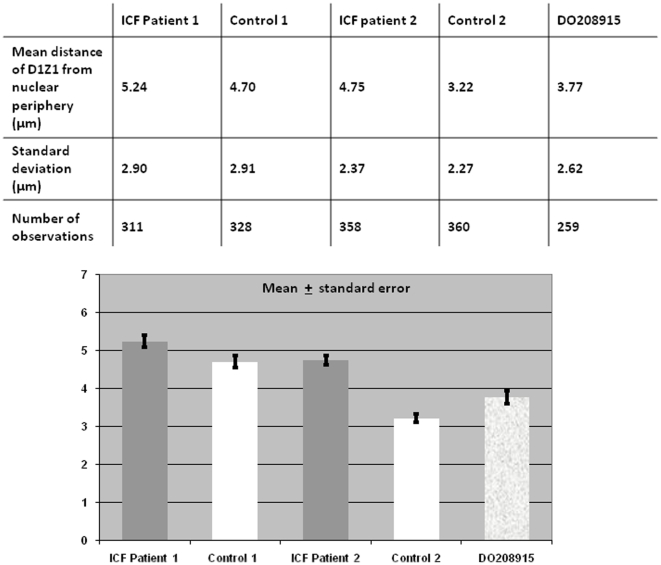
Chromosome 1 juxtacentromeric heterochromatin positioning in relation to the extreme nuclear periphery: distance measurements in ICF cells and controls.The average distance between the centroid of the chromosome 1 juxtacentromeric heterochromatic signal and the extreme nuclear periphery, as defined by the edge of the DAPI nuclear staining, was calculated in unsynchronised B-lymphoblastoid cells from ICF Patients 1 and 2, Controls 1 and 2 and DO208915. When performing a Kolmogorov-Smirnov test, the distance of chromosome 1 juxtacentromeric heterochromatin from the nuclear periphery is significantly greater in ICF cell lines when compared to control cell lines (D = 0.1405, P<0.001).